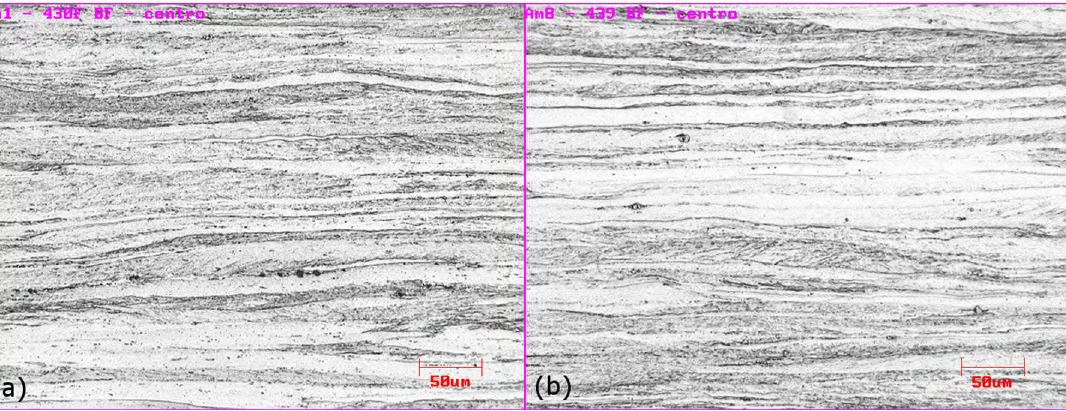
Figure 2. Microstructure of the cold rolled samples (CR). (a) 430Nb CR and (b) ASTM 439 CR